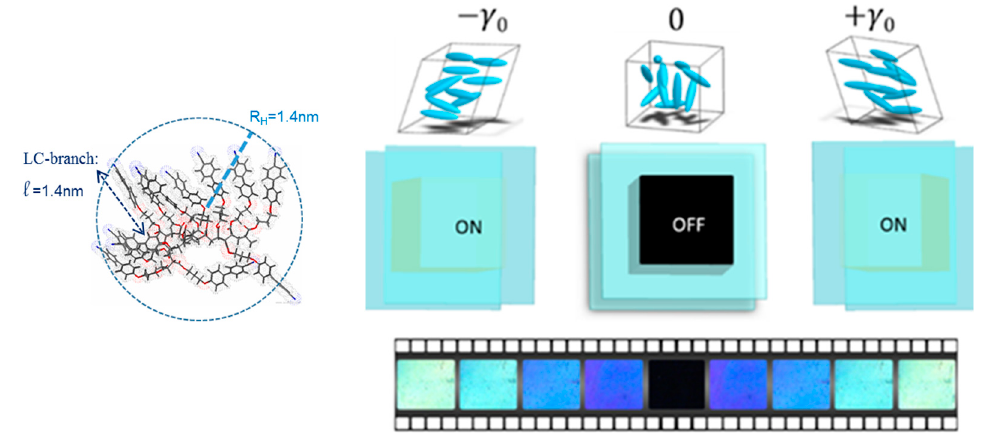
Figure 2. The isotropic phase exhibits a “mechano-stimuli responsive” behavior upon applying an oscillatory strain wave γ = γ 0 · sin( ω · t ), where γ 0 is the rate of the displacement δ l to the slab thickness e ( γ 0 = 10%, ω = 0.5 Hz, e = 0.250 mm, quartz substrate). Photos recorded between crossed polarizers using a polychromatic light, sample: 12 monomer units of cyanobiphenyl acrylate displaying the following phase sequence: Tg–54 ◦ C–S A –80 ◦ C–I (from [22]). Link for the video: https://www. youtube.com/watch?v=0NPjNG6FkTE. LC: liquid crystalline